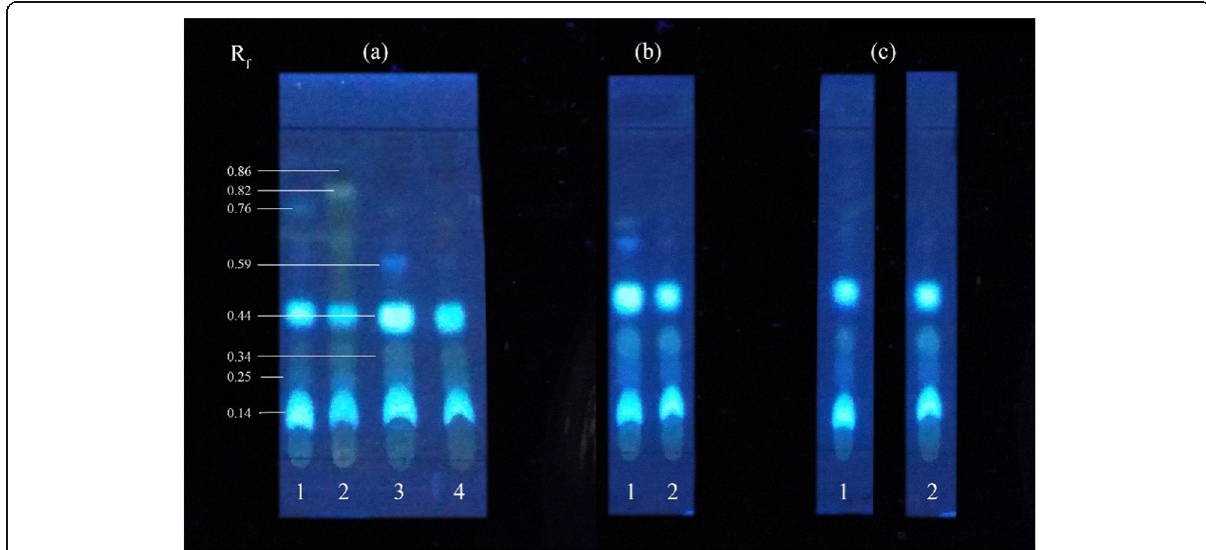
Fig. 8 TLC profiles of biologically elicited G. walla calli ( a ) P. parasitica (1) 25 mg/L, (2) 50 mg/L, 75 mg/L, 100 mg/L; ( b ) T. viride (1) 75 mg/L, (2)